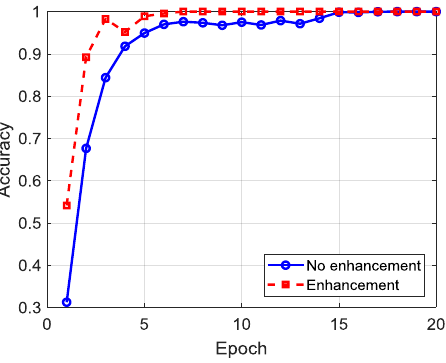
Figure 12. Comparison of convergence of DCNN with and without image enhancement.